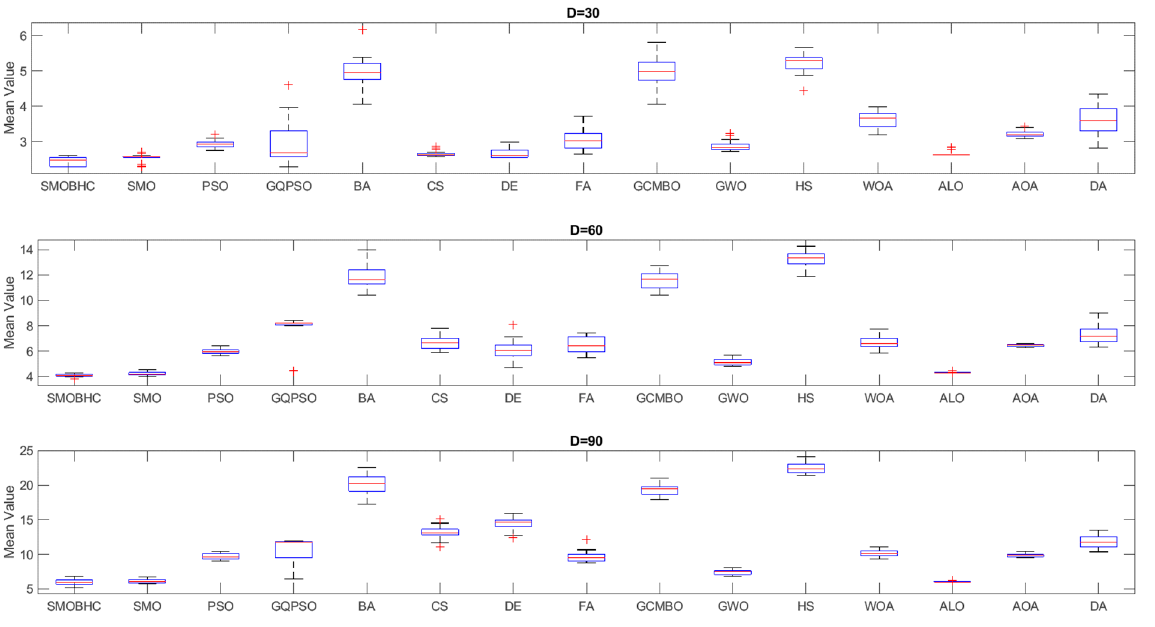
Figure 11. Boxplot graphs of mean values relative to all algorithms for battlefield 1 with 𝐷 = 30 , 60, and 90.